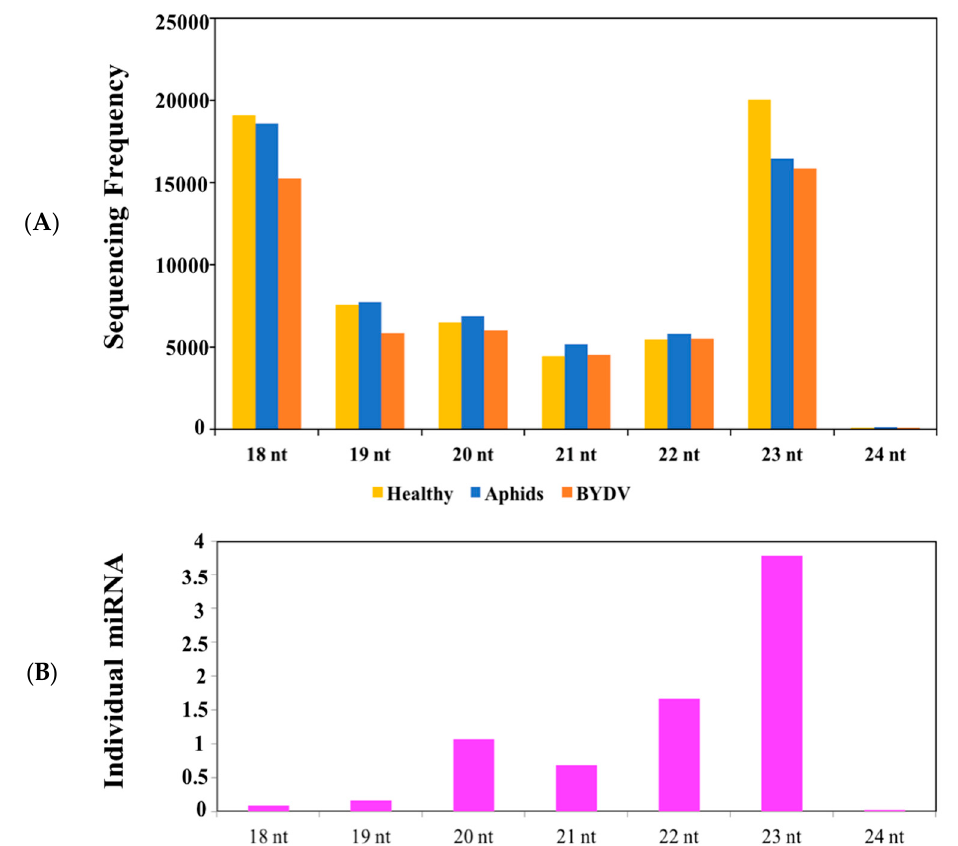
Figure 3. Length distribution of individual miRNAs. ( A ) Total calculated reads of all miRNAs from healthy, aphid-infested non-infected, and BYDV-infected plants. ( B ) Individual miRNAs.